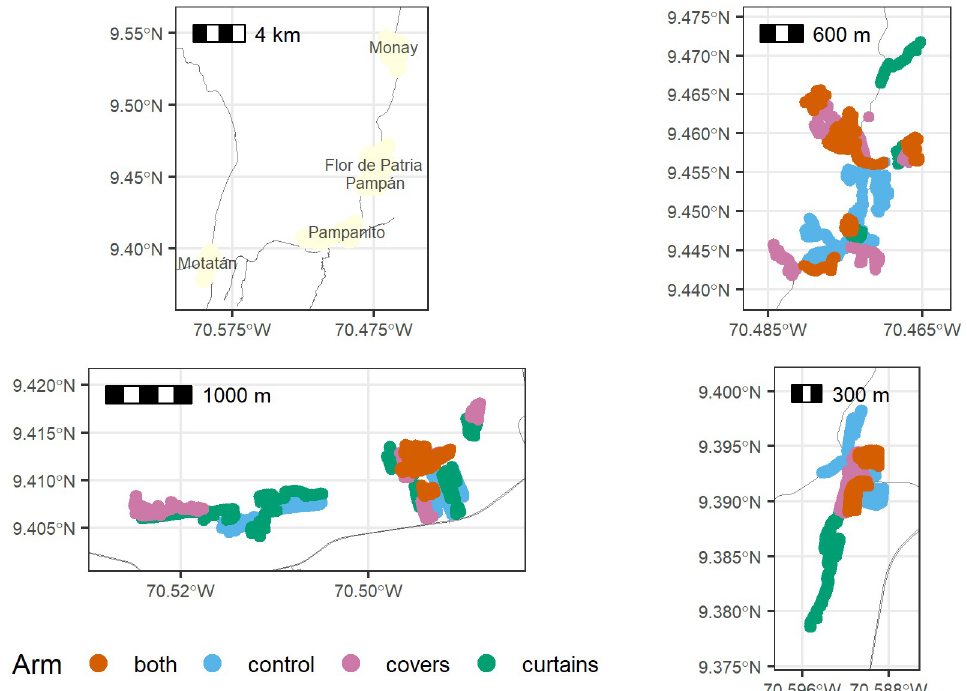
Fig 1. Maps of the study site. Top left panel: complete study site. Monay is the external control area, and the other four areas, in which clusters were randomized, are shown in the other three panels. Top right: Flor de Patria and Pampa´n. Bottom left: Pampanito. Bottom right: Motata´n. Solid lines are roads. The colour coding of clusters shows clusters allocated to jar covers only, curtains only, both jar covers and curtains, or control. The base map includes roads from Open Street Map (www.openstreetmap.org) accessed via the R package “osmdata”.